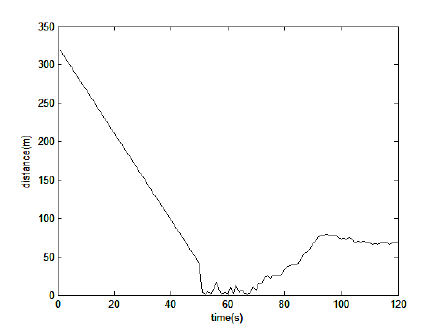
Fig. 4. RMS error in the x direction.